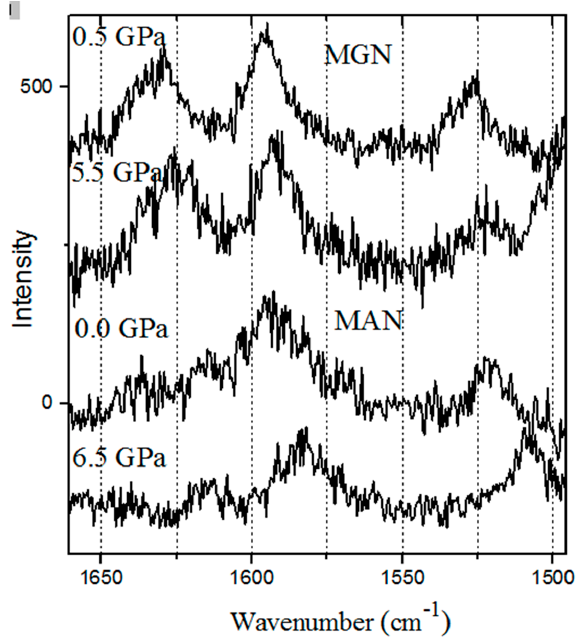
Figure 2. Raman spectra of monoglycine nitrate (MGN) and mono- L -alaninium nitrate (MAN) for two different pressures, showing the region where it is expected the observation of mode associated with the bending of NH 3 + .